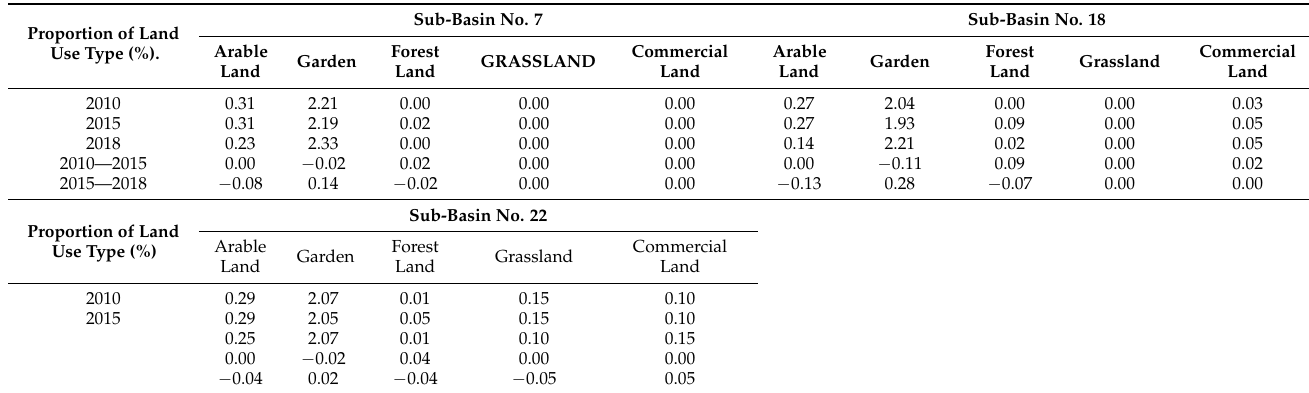
Table 7. Area ratio of land use types in sub-catchments.